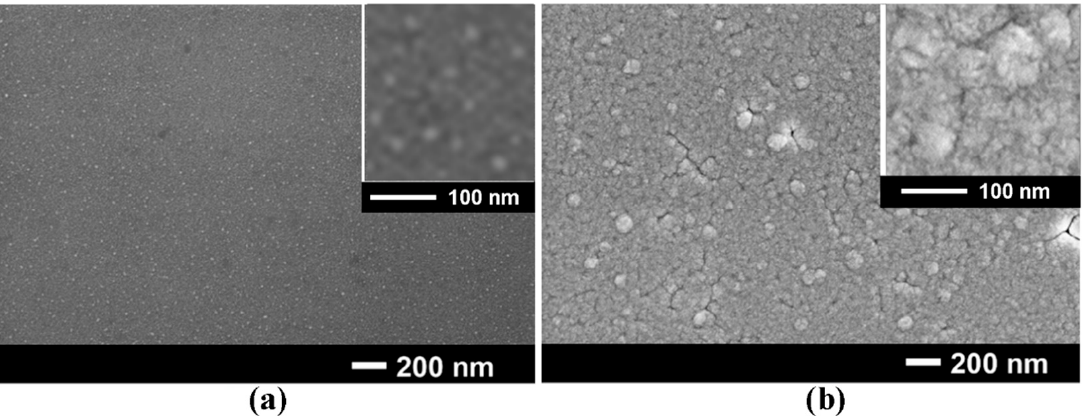
Figure 2. SEM images of permalloy films on GaAs substrate after 40 s ( a ) and 60 s ( b ) deposition.